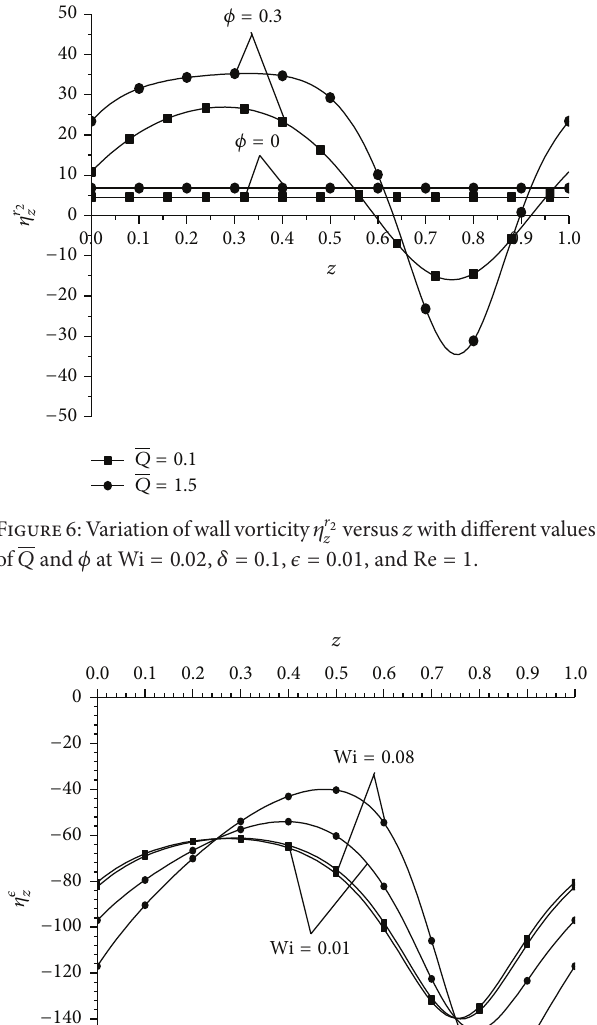
pressure gradient) and the upper left-hand quadrant denotes the region of retrograde pumping (or backward pumping) where 𝑄 < 0 and Δ𝑝 > 0 (adverse pressure